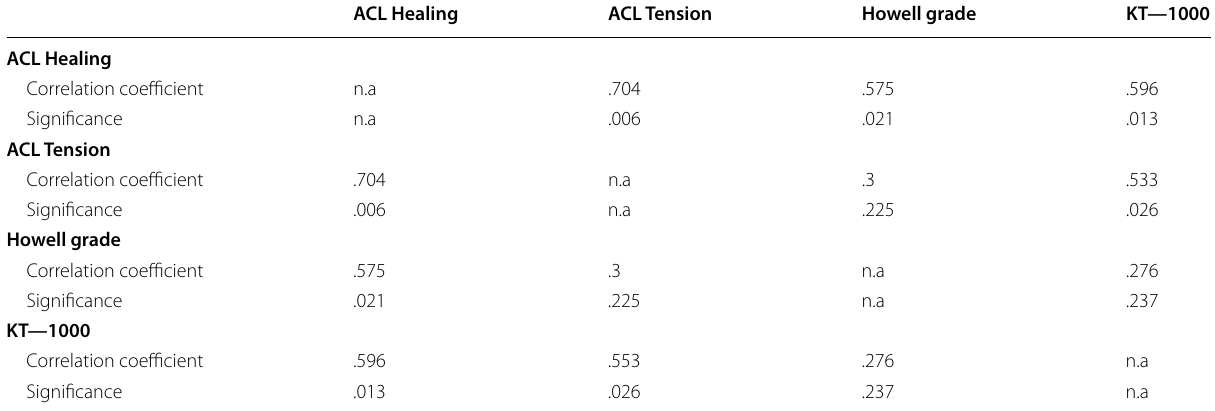
ACL Anterior cruciate ligament tears, n.a. Not